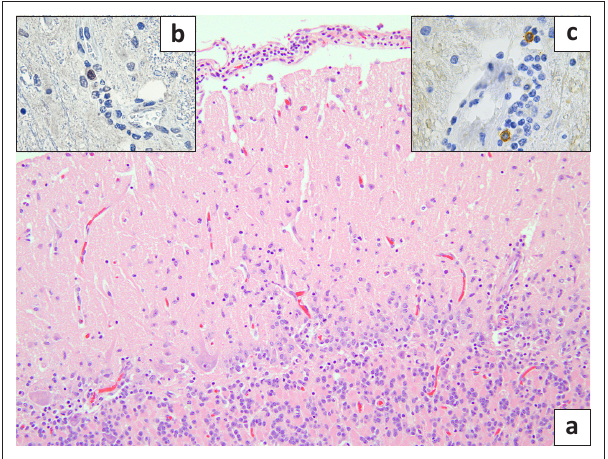
FIGURE 6: (a) Cerebellum of Case 4 showing molecular layer gliosis with glial flares and intermittent mild mononuclear meningitis. (b) Case 4 brainstem vessel with a perivascular immunohistochemistry multiple myeloma oncogene 1+ (dark nucleus) plasma cell. Multiple myeloma oncogene 1 immunoperoxidase using polymer DAB as chromogen and haematoxylin counterstain x 1000. (c) Case 4 brainstem vessel perivascular immunohistochemistry cluster of differentiation 20+ (brown) B-lymphocytes/plasma cells. Cluster of differentiation 20 immunoperoxidase using LSAB+ DAB as chromogen and haematoxylin counterstain x 1000.